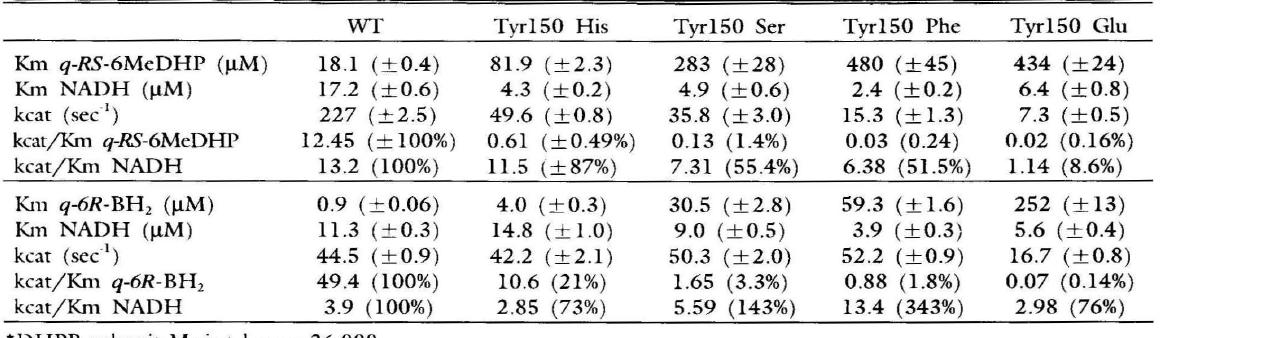
Table 2. Kinetic parameters of mutated human DHPR* 0.1 M Tris-HCI buffer (pH 7.4) at 25°C WT Tyr150 His Tyr150 Ser Tyr150 Phe Tyr150 Glu